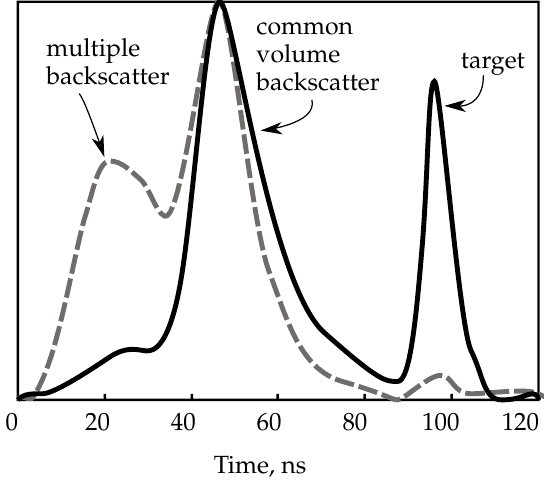
Figure 4. Representative normalized returning signal from an LLS. At higher turbidity (dashed gray line), the backscatter peak is stronger and the target return is weaker. The common volume backscatter is light that has been deflected once, whilst the multiple backscatter has been deflected twice or more